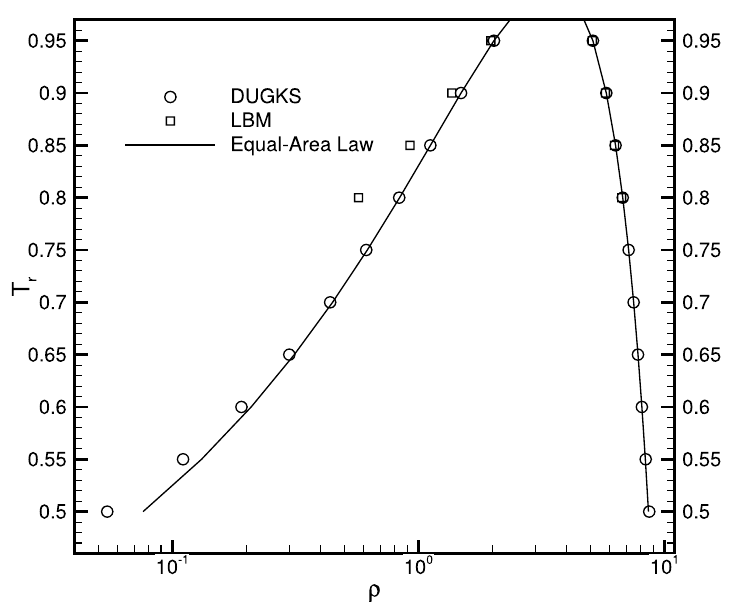
Fig. 1 Coexisting curves produced by DUGKS and LBM, τ = 0.3 , α =